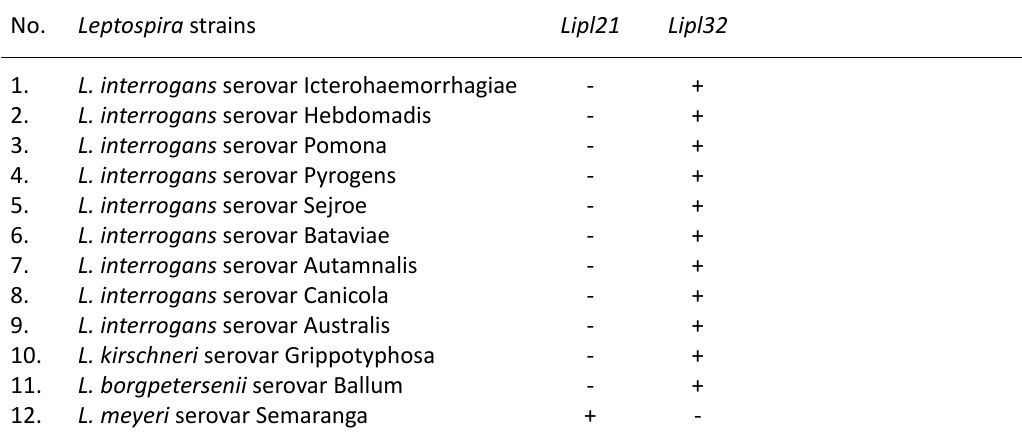
Table 1. List of Leptospira strains used in this study No.